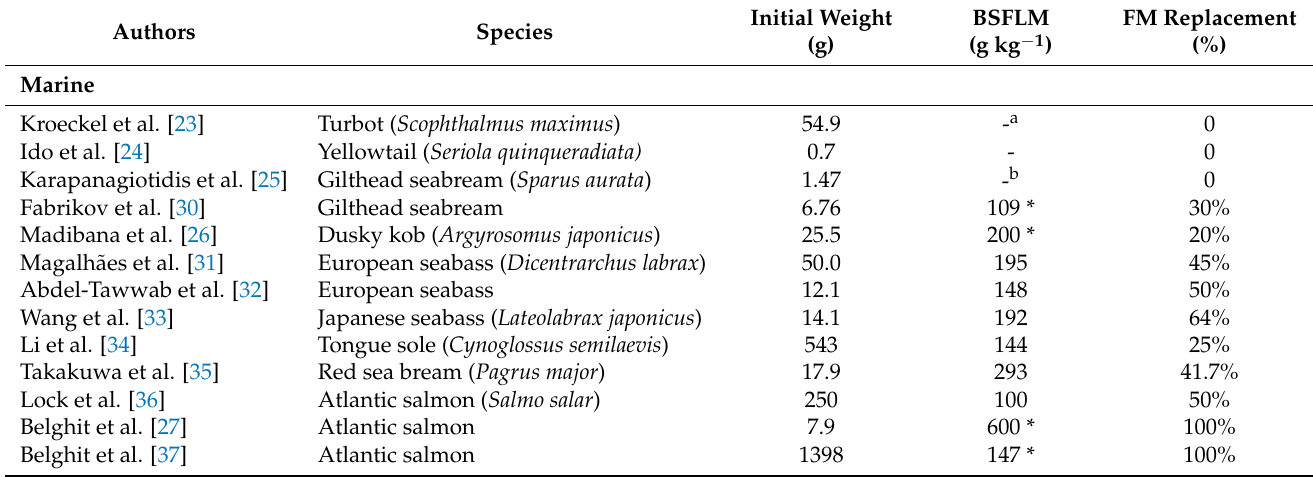
Table 1. Fishmeal (FM) replacement level (%) and corresponding dietary amount (g kg − 1 diet) of black soldier fly larvae meal (BSFLM) included without negative effects on growth performance in marine and freshwater fish